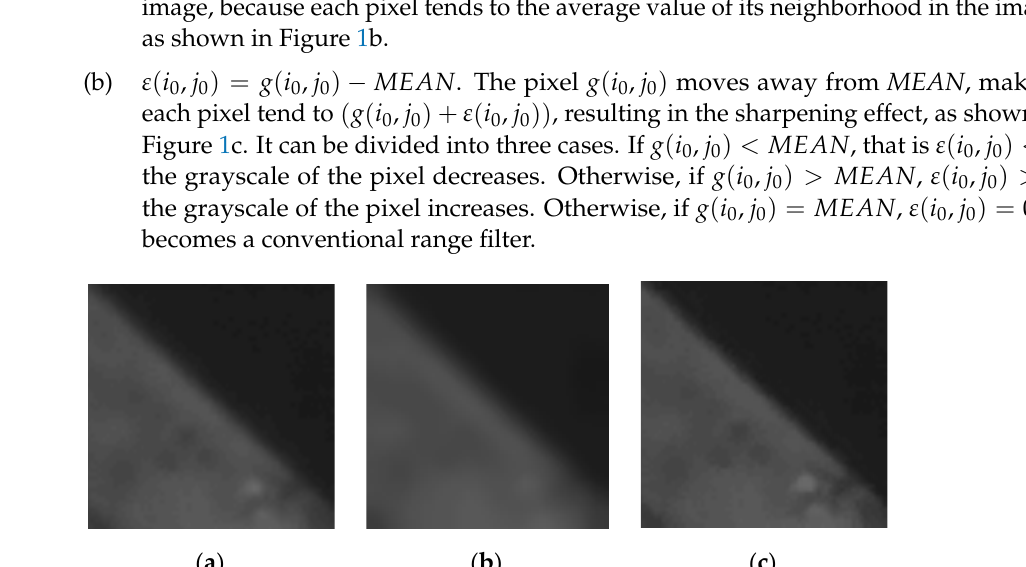
Figure 1. The different results of the improved range filter with different grayscale offsets. ( a ) Orig- inal image; ( b ) (cid:2013)((cid:1861) (cid:2868) ,(cid:1862) (cid:2868) ) = (cid:1839)(cid:1831)(cid:1827)(cid:1840) − (cid:1859)((cid:1861) (cid:2868) , (cid:1862) (cid:2868) ) ; ( c ) (cid:2013)((cid:1861) (cid:2868) , (cid:1862) (cid:2868) ) = (cid:1859)((cid:1861) (cid:2868) , (cid:1862) (cid:2868) ) − (cid:1839)(cid:1831)(cid:1827)(cid:1840) . image; ( b ) ε ( i ) = MEAN − g ( i 0 , j 0